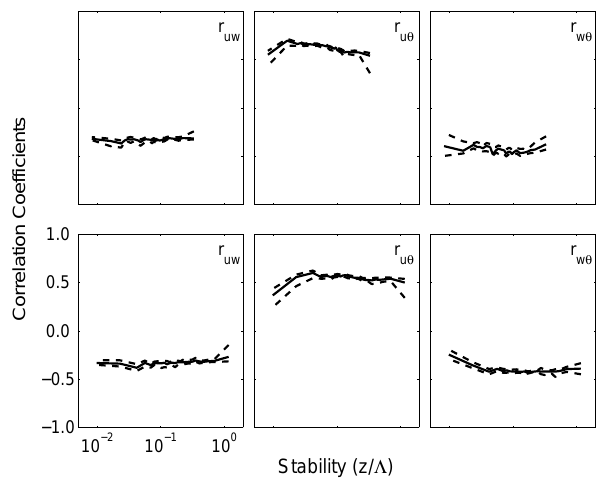
Fig. 4. The panels from left to right represent correlation co- efficients r uw , r uθ , and r wθ , respectively; where r uw = h u 0 θ 0 i h w 0 θ 0 i c c r uθ = , and r wθ = . The upper and lower panels cor- σ u σ θc σ w σ θc respond to the 3.1m and the 7m sonic anemometers, respectively. All the panels have identical abscissa and ordinate limits.